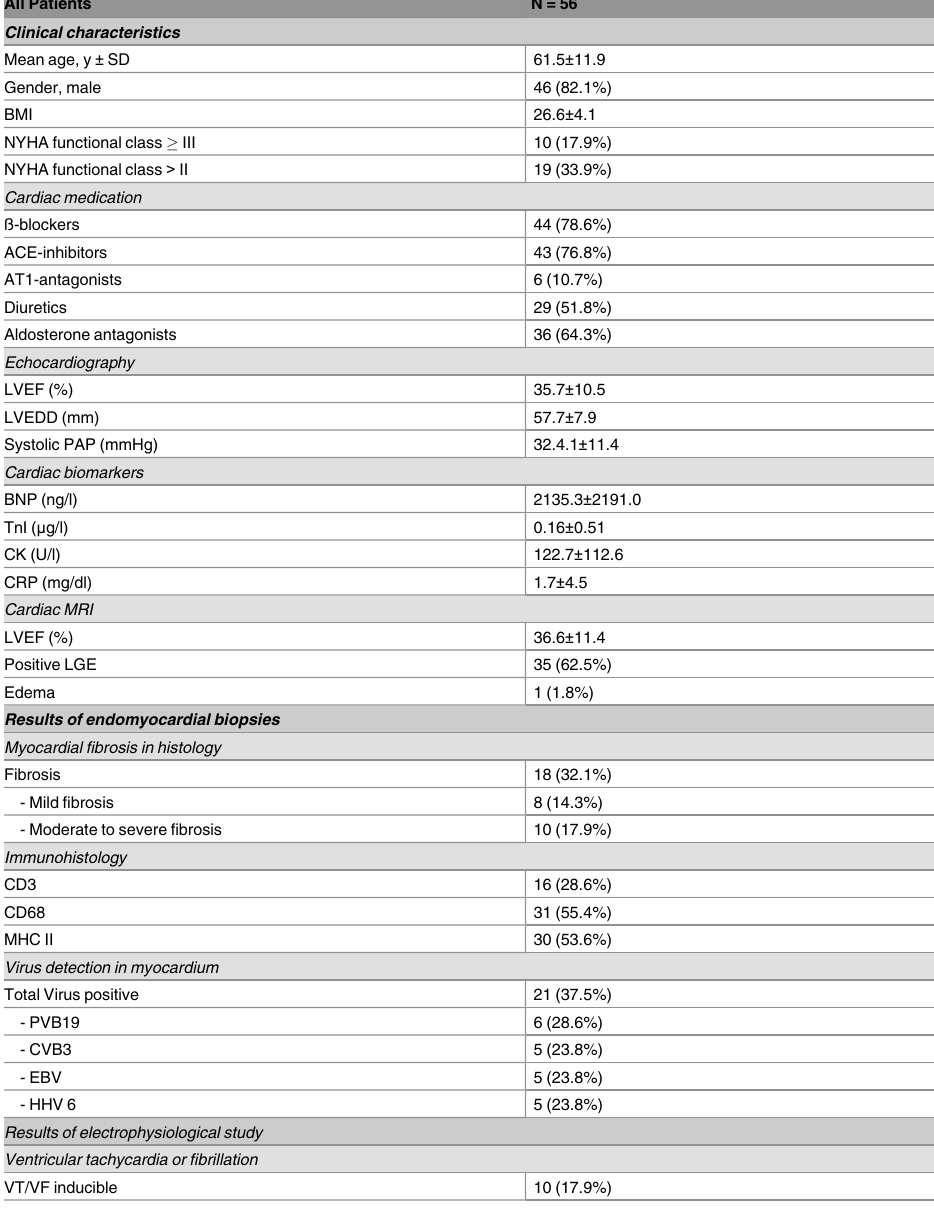
Table 1. Patients’ demographics and baseline characteristics. All